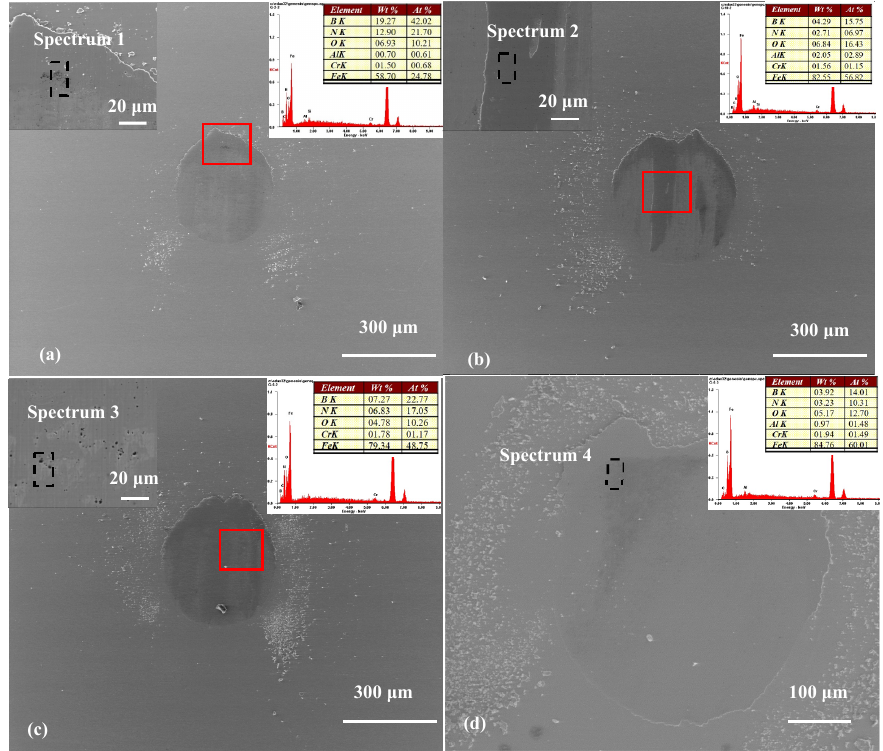
Figure 3. SEM wear morphologies of AISI 52100 under different loads: ( a ) 2 N; ( b ) 5 N; ( c ) 10 N; ( d ) 15 N. The inserts on the left of ( a – c ) are the high magnification of the corresponding red box posi ‐ tions. The EDS result on the right of ( a – d ) represents the elements on the black dashed box.